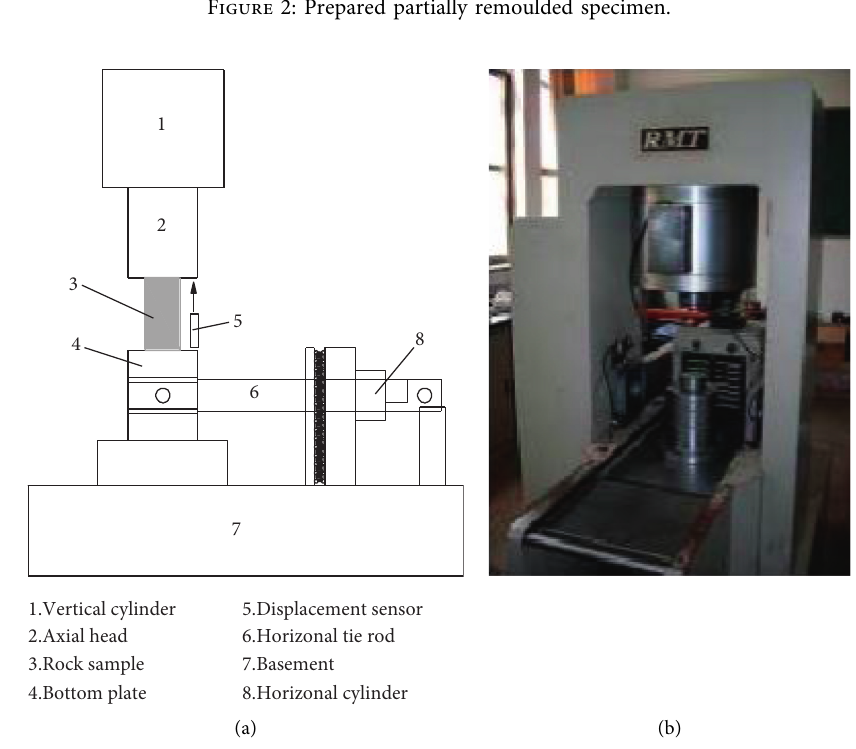
Figure 3: RMT-150B rock electrohydraulic servo test